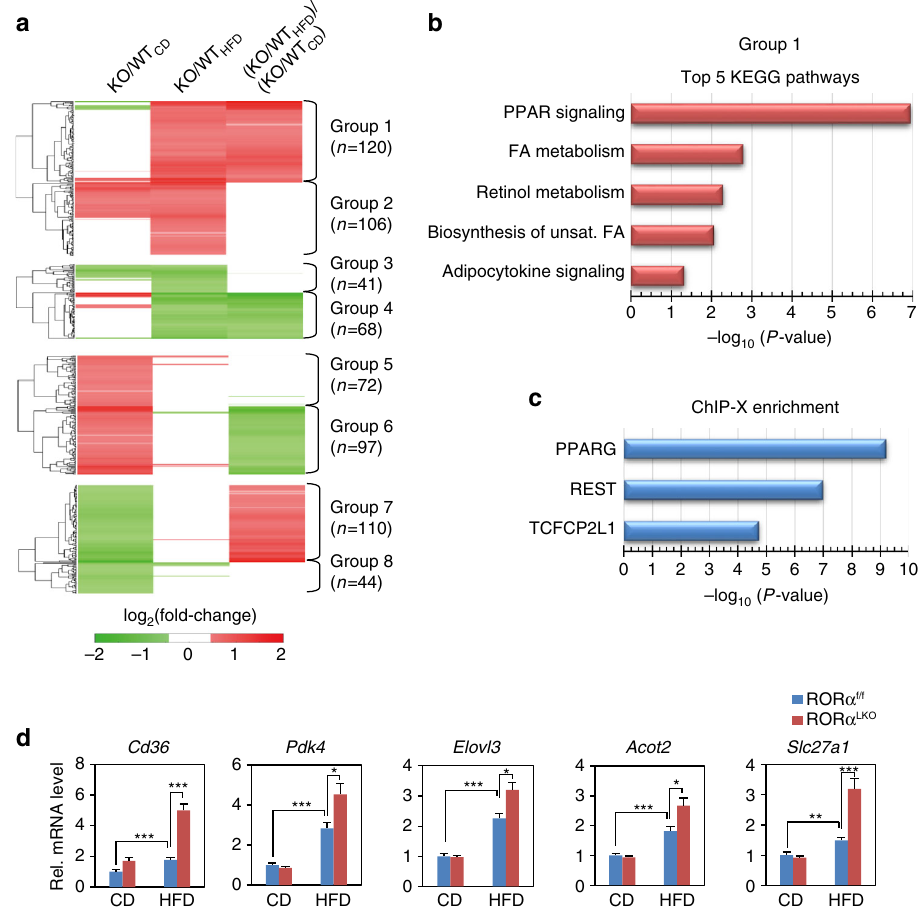
Fig. 3 Transcriptome analysis of hepatic gene expression pro fi le in ROR α LKO mice. a Up- and down-regulated genes in ROR α LKO compared to ROR α f/f mice. These genes were categorized into four groups of the up- (Groups 1, 2) and down-regulated genes (Groups 3, 4) in HFD-fed ROR α LKO . Besides Groups 1 – 4, remain genes were also categorized into four groups of the up- (Groups 5, 6) and down-regulated genes (Groups 7, 8) in CD-fed ROR α LKO . Groups 1, 2 (or Groups 3, 4) were further divided by the speci fi city of the ROR α effect under HFD condition. Log 2 -fold changes in the following comparisons were displayed: ROR α LKO /ROR α f/f HFD , ROR α LKO /ROR α f/f CD and (ROR α LKO /ROR α f/f HFD )/(ROR α LKO /ROR α f/f CD ). Hierarchical clustering of the DEGs in Groups 1 – 8 (Euclidian distance as a dissimilarity measure and average linkage) were used to display the log 2 -fold changes. b KEGG pathways enrichment analysis for the genes in Group 1. The bars represent the enrichment scores, -log 10 ( P value). c TF enrichment analysis for the genes in Group 1 using ChEA2 software. Top 3 TFs are shown. The bars represent the enrichment scores, -log 10 ( P value). d Expression levels of group 1 genes